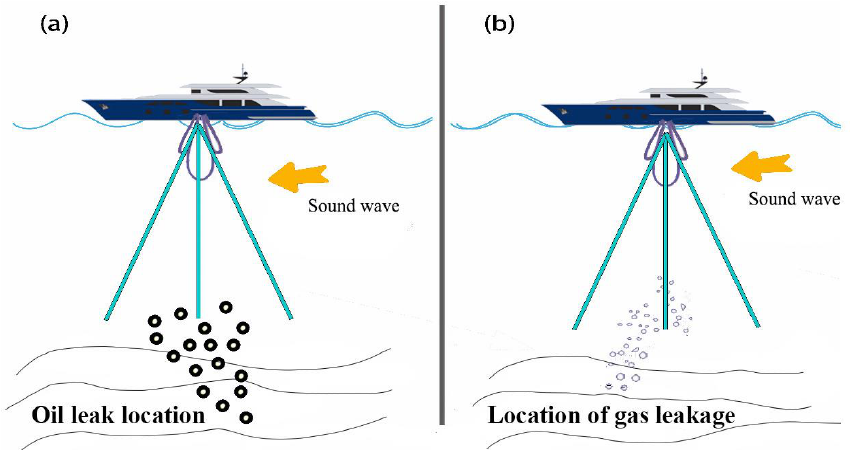
Figure 4. ( a ) Acoustic monitoring of oil droplets; ( b ) acoustic monitoring of leaking